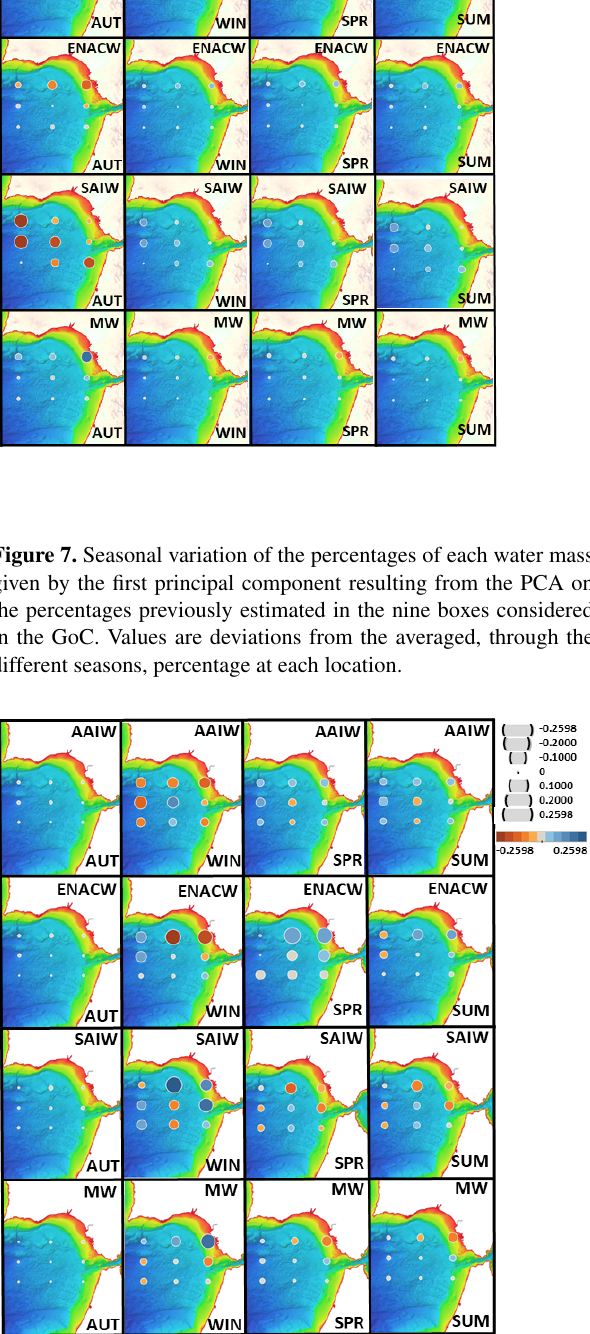
Figure 8. As Fig. 7 but for the second principal component.